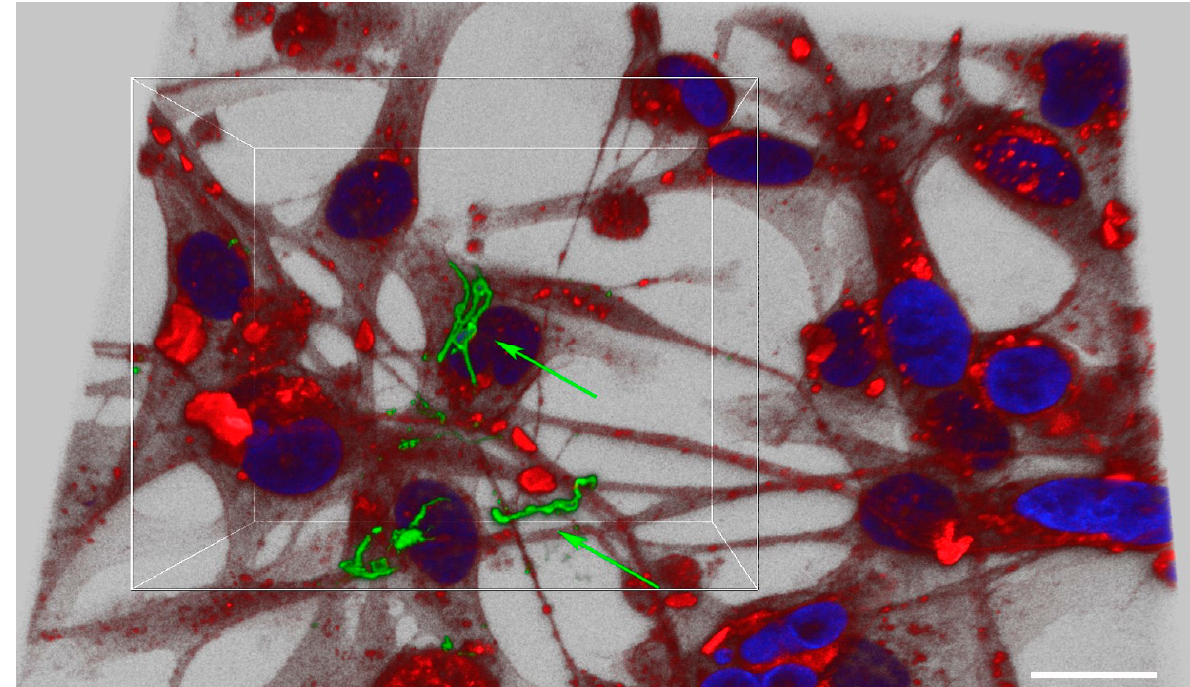
Figure 1. Representative confocal microscopy images of MCF 10A (Panel I) and MDA-MB-231 (Panel II) mammalian epi- thelial cells infected with B. burgdorferi . The cells were co-cultured with B. burgdorferi for ( B ) 24 h, ( C ) 48 h, and ( D ) 72 h. ( A ) Uninfected cells treated only with co-culture media were used as a control. CM-Dil membrane stain was used to label the cells (red), DAPI was used to stain the nucleus (blue) and polyclonal anti- B. burgdorferi was used to visualize B. burgdor- feri cells (green), as described in the Material and Methods. The representative images were taken at 630X with a scale bar of 20 μ m. White arrowhead represents an invading spirochete and white arrow shows small B. burgdorferi aggregates inside the cells.